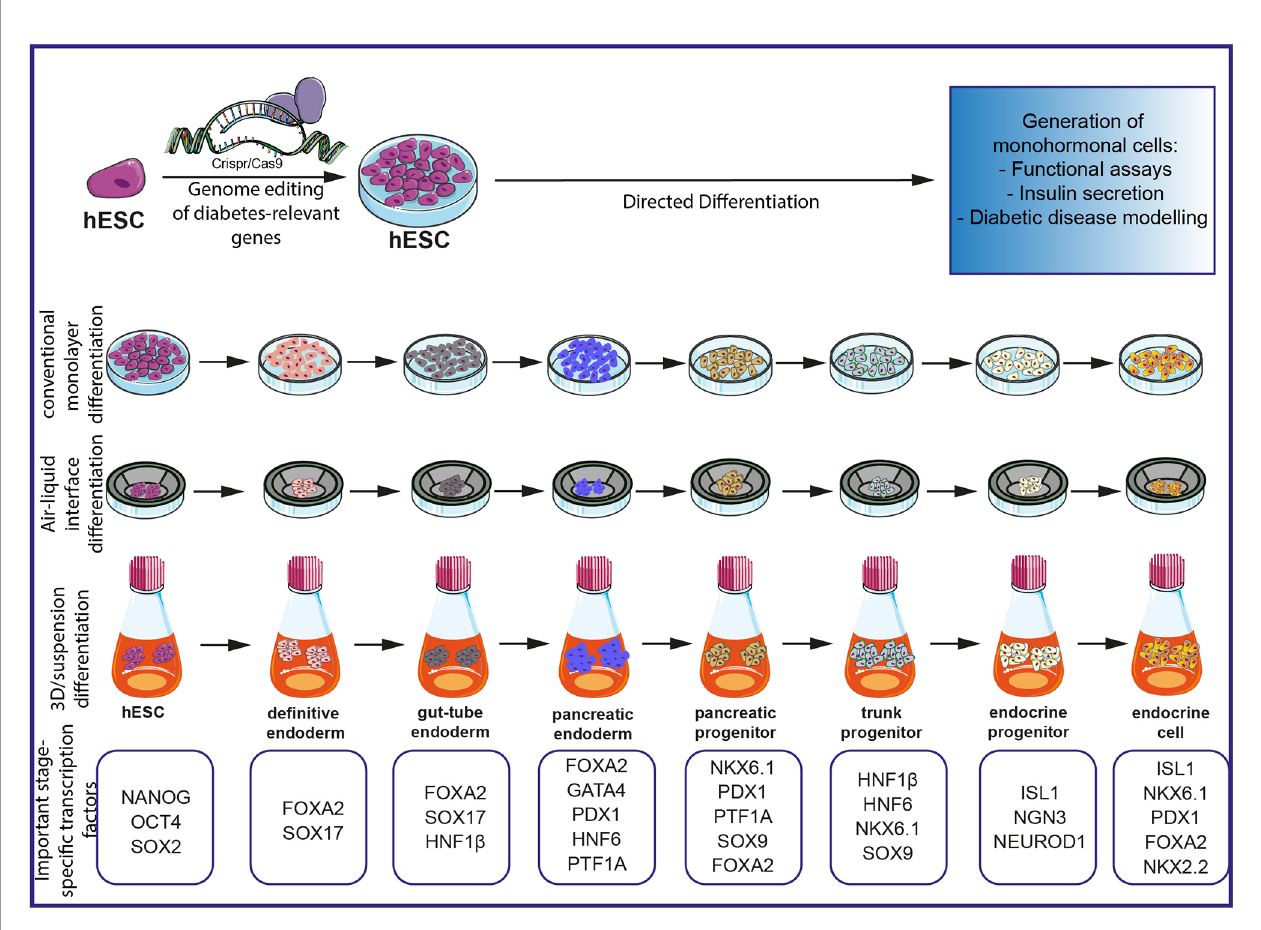
FIGURE 1 | Schematic overview of currently existing protocols for the investigation of diabetes on an hPSC-based platform. Gene editing with CRISPR/Cas9 allows precise editing of diabetes-relevant genes and generation of hESC for further differentiation experiments. Different differentiation protocols allow the generation of monohormonal cells by passing through different milestones during embryonic development. Important stage-speci fi c transcription factors are indicated below the schematics. Subsequent analysis of monohormonal b -cells, including insulin secretions assays, can be performed and generate hypotheses about the in fl uence of speci fi c genetic variants. The fi gure was modi fi ed from Smart Servier Medical Art (https://smart.servier.com/) under a Creative Common Attribution 3.0 Generic